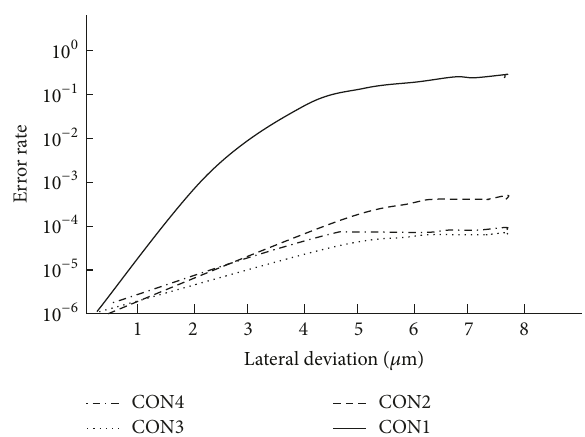
Figure 8: The relationship between error rate and lateral deviation (wavelength 850).